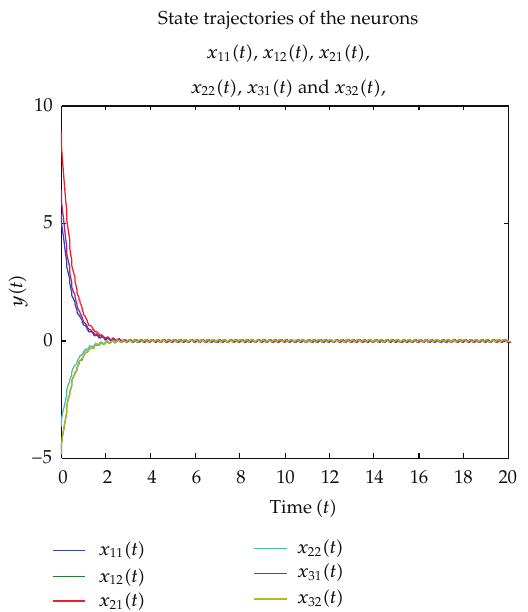
Figure 3: State trajectories of the neurons x 11 , x 12 , x 21 , x 22 , x 31 , x 32